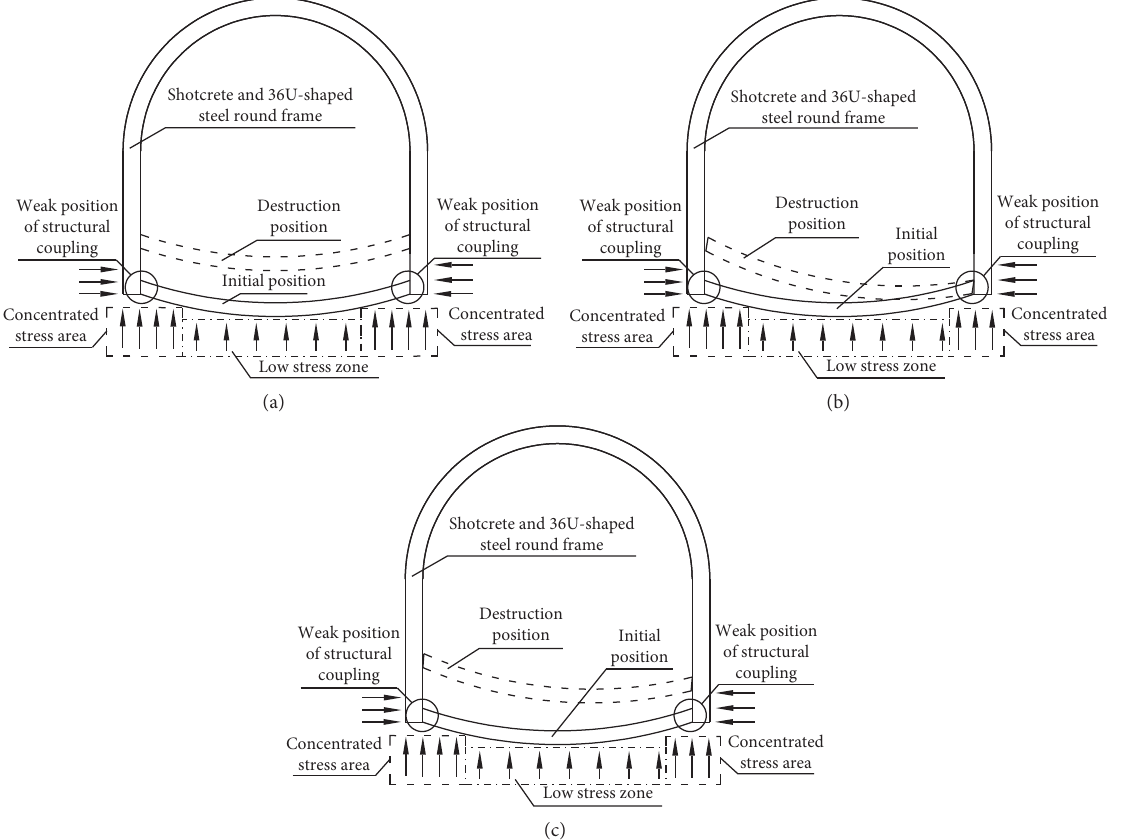
Figure 3: Instability types of inverted arch structures. (a) Sliding upward. (b) Rotating upward. (c) Sliding-rotating